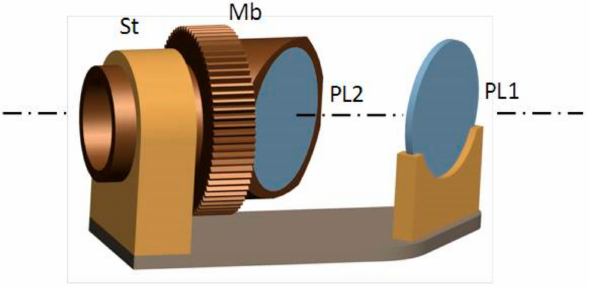
Figure 4. A three-dimensional (3D) view of the measurement